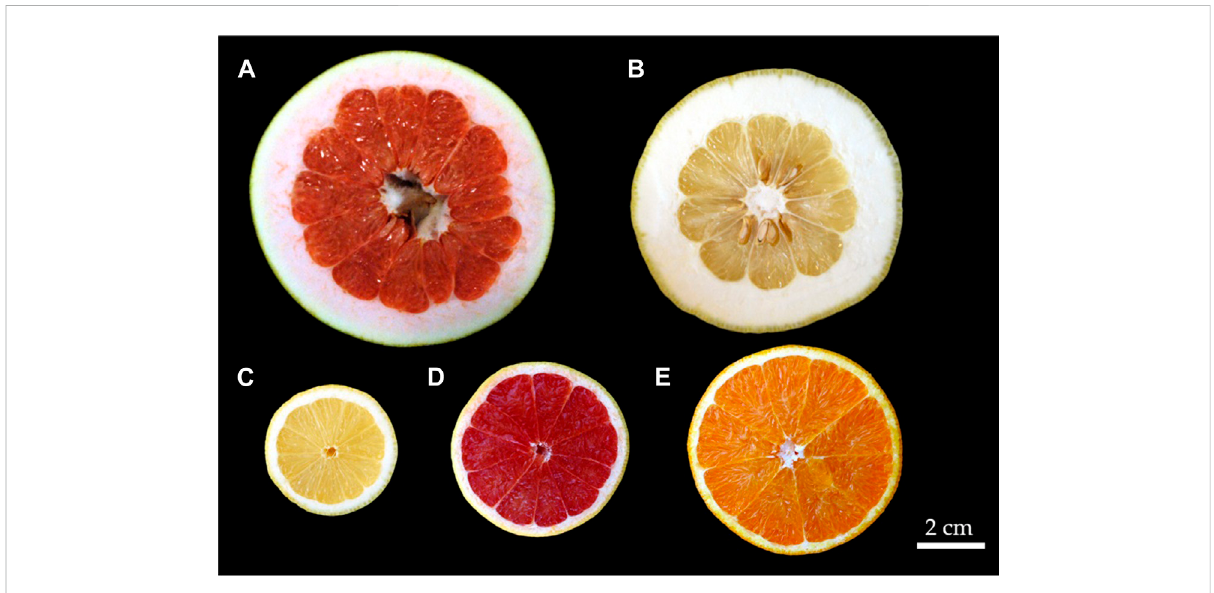
FIGURE 2 Equatorial cross-sectionof thefruitsof (A) pomelo ( C. maxima ) (B) citron ( C. medica ) (C) lemon ( C. x limon ) (D) grapefruit ( C. x paradisi ), and (E) orange ( C. x sinensis ).